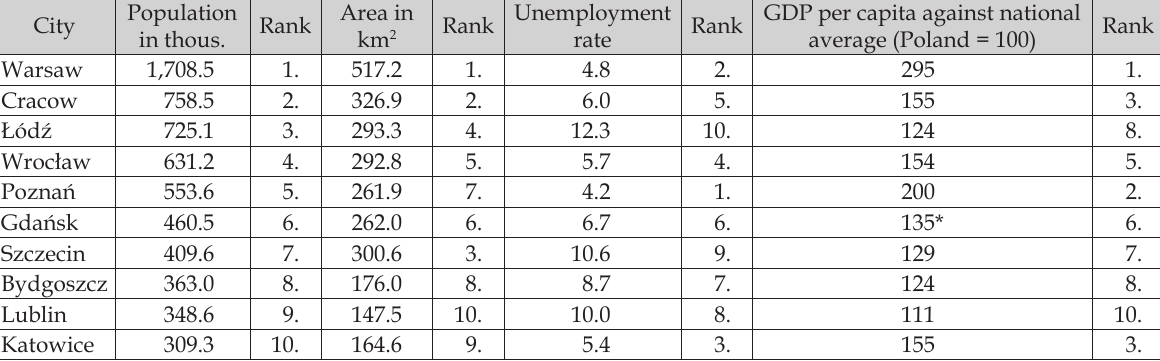
*Figure for the Tri-City of Gdańsk, Sopot and Gdynia. Source: own compilation based on the Central Statistical Office (GUS) (population in 2011, area in 2011, unemployment rate in November 2013) and PwC 2011 (per capita GDP rates in